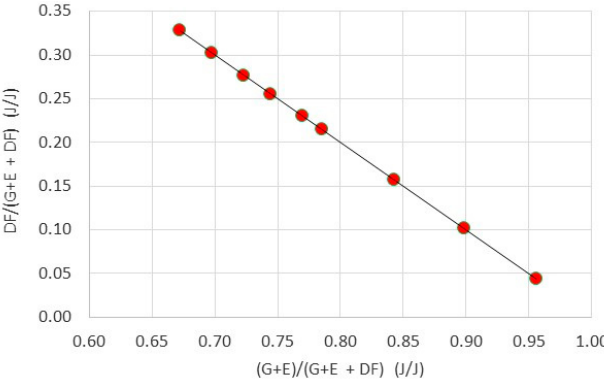
Figure 1. Correlation between DF fraction vs. G + E fraction by energy.